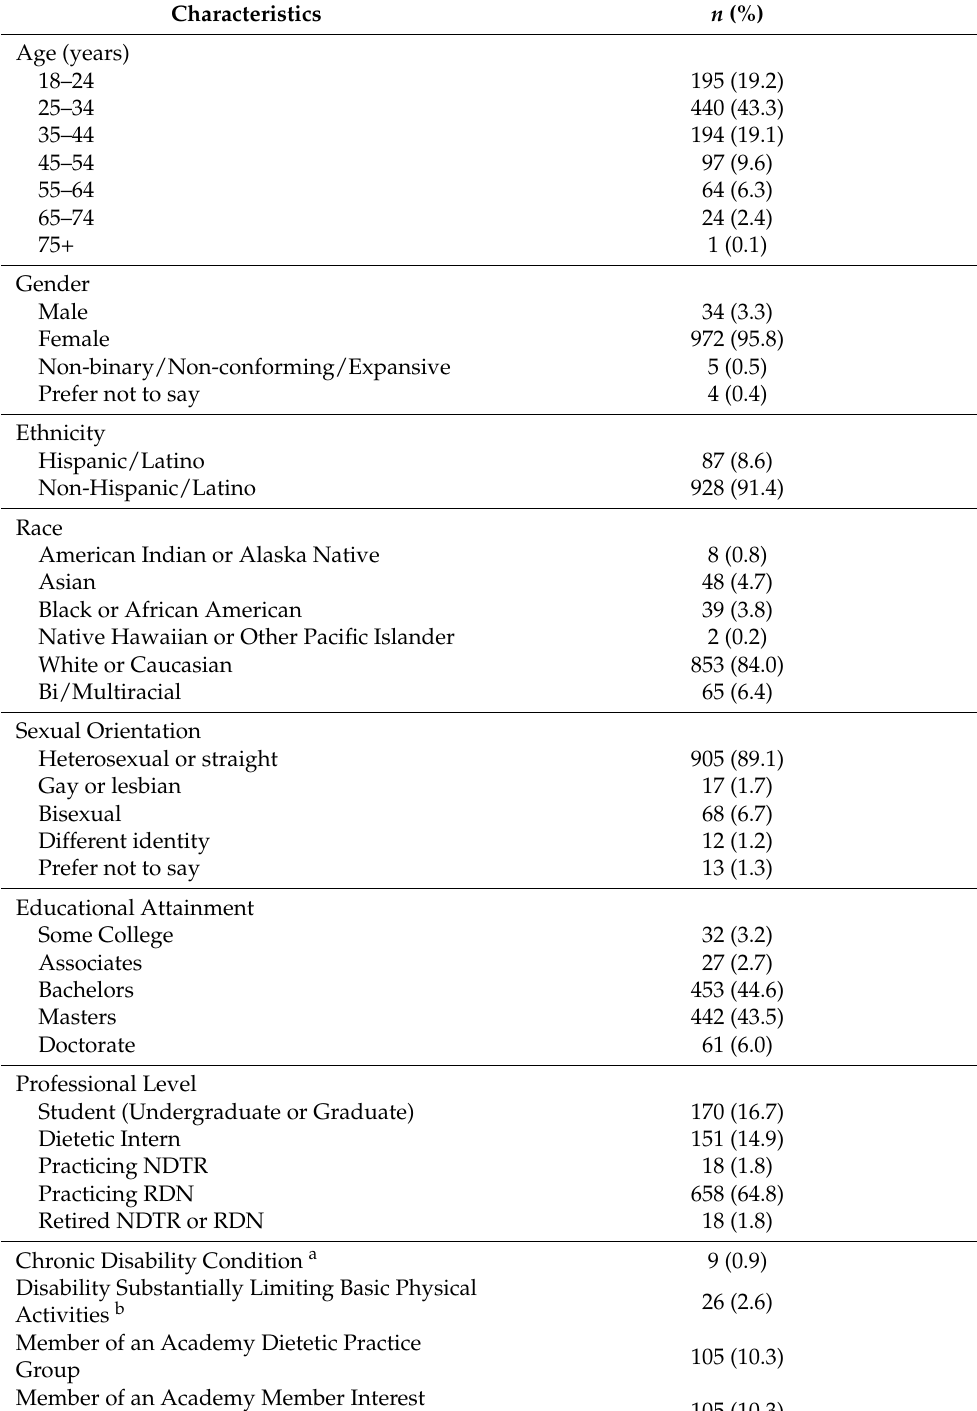
Table 1. Demographics of Non-Representative Convenience Sample of 1015 Dietetics Students, Dietetic Interns, and Currently Practicing and Retired Nutrition and Dietetic Technicians Registered and Registered Dietitian Nutritionists Participating in an Online Survey on the Impostor Phenomenon.